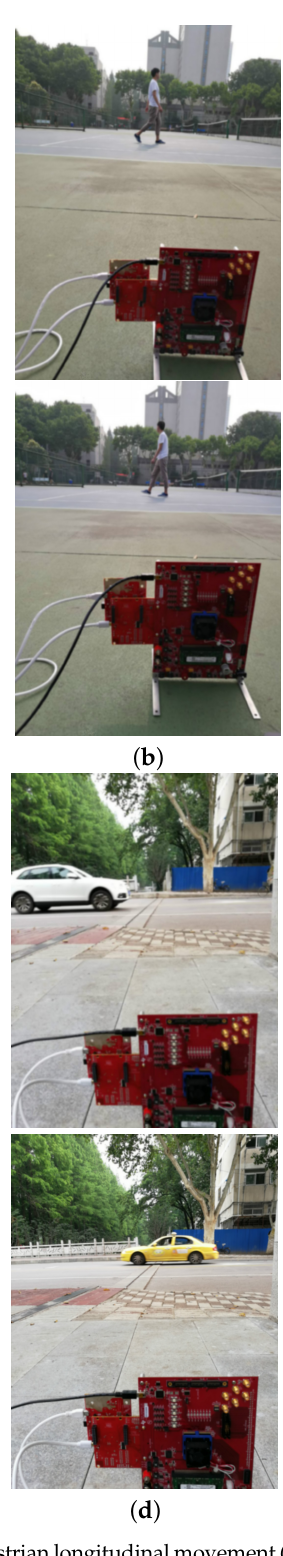
Figure 3. Typical motion scenes of pedestrian and vehicle. ( a ) pedestrian longitudinal movement (forwards and towards); ( b ) pedestrian lateral movement (left to right and right to left); ( c ) vehicle longitudinal movement (forwards and towards); ( d ) vehicle lateral movement (left to right and right to